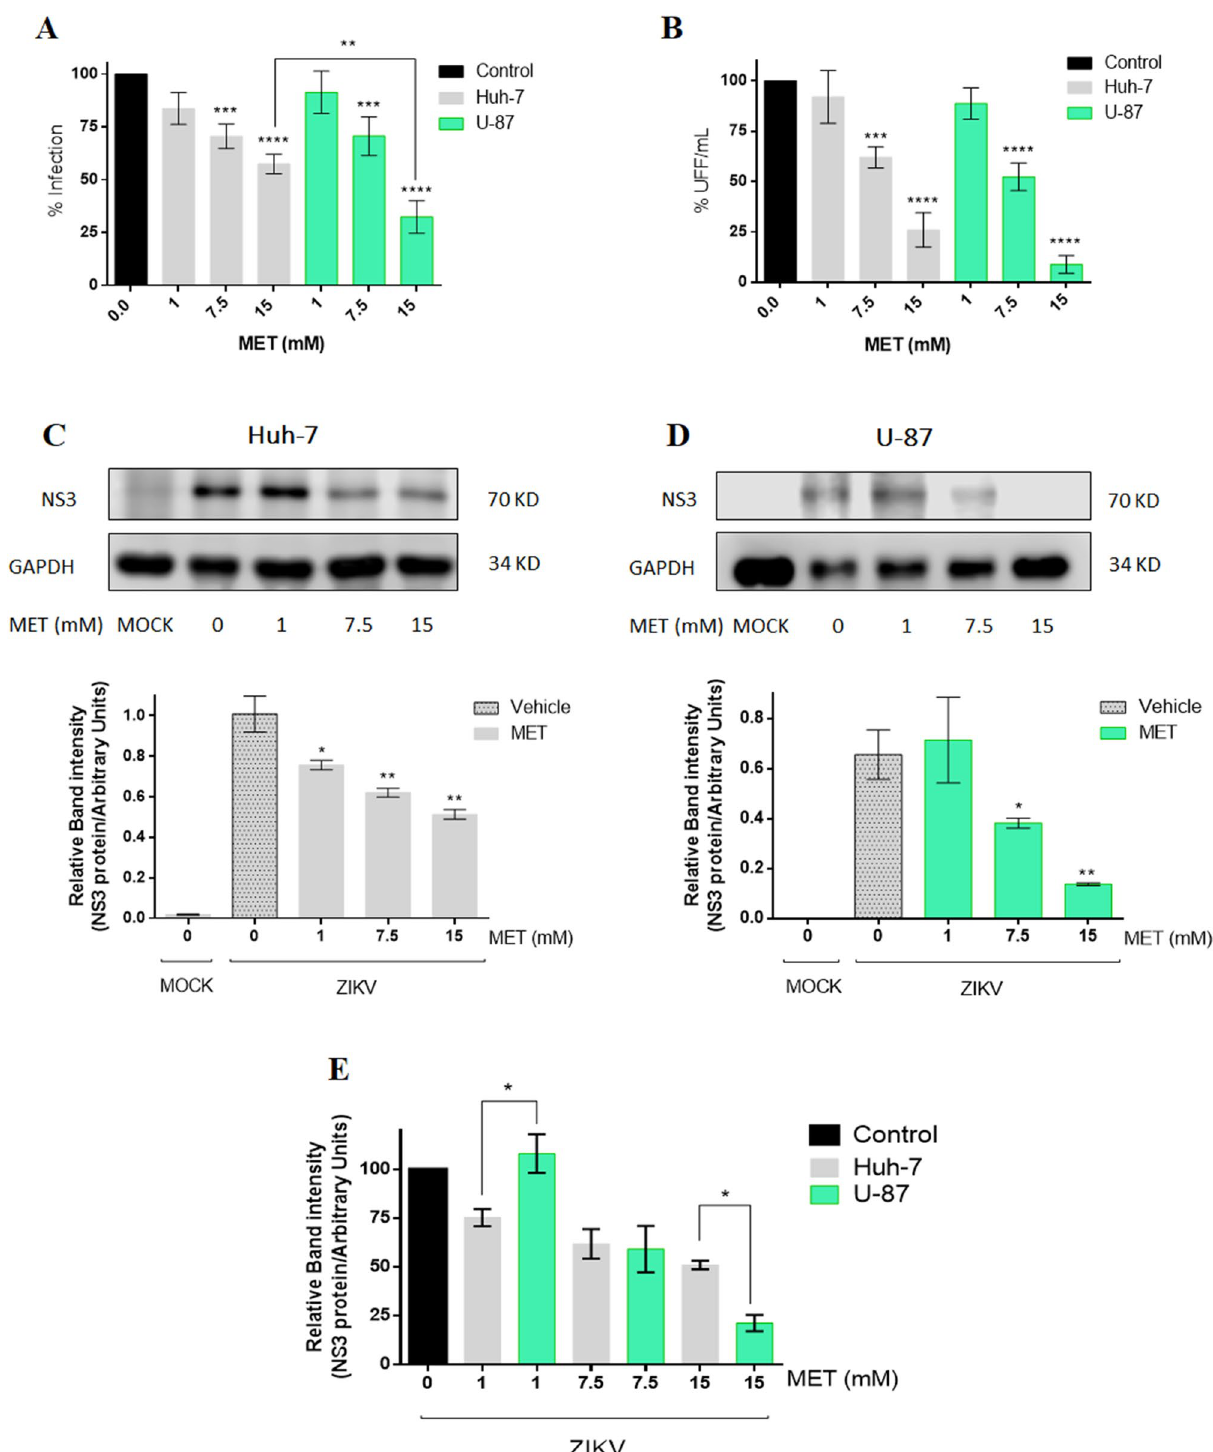
Figure 2. Met reduces viral yield and viral protein synthesis during the ZIKV infection in Huh-7 and U-87 cells. The Huh-7 and U-87 infected cells were treated with Met (1,7.5,15 mM) for 24 h. ( A ) Infected cells analyzed by flow cytometry. ( B ) Viral titers of the collected supernatants analyzed by foci forming units (FFU) assay. The NS3-ZIKV protein was analyzed by western blot in ( C ) Huh-7 cells, and ( D ) U-87 cells; the densitometric analysis is shown below. ( E ) Statistical analysis of densitometry between both cell lines. The results are presented in percentages considering as 100% the infected cells untreated (Control). The graphs represent the means ± SD of n = 3 independent experiments realized by duplicated. *p = 0.0332, **p = 0.0021, ***p = 0.0002 ****p <